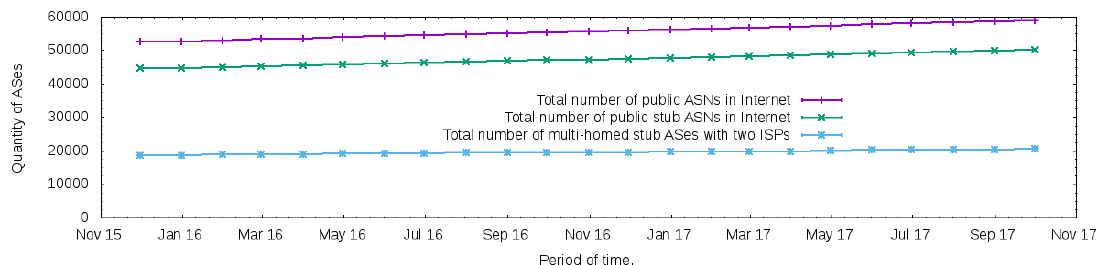
Figure 4. The total number of multi-homed stub ASes is common in recent months of the Internet.